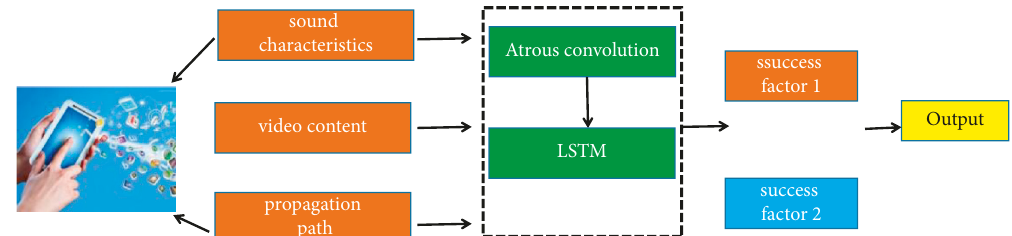
Figure 1: Design of atrous convolution and LSTM methods in self-media content and propagation path prediction.